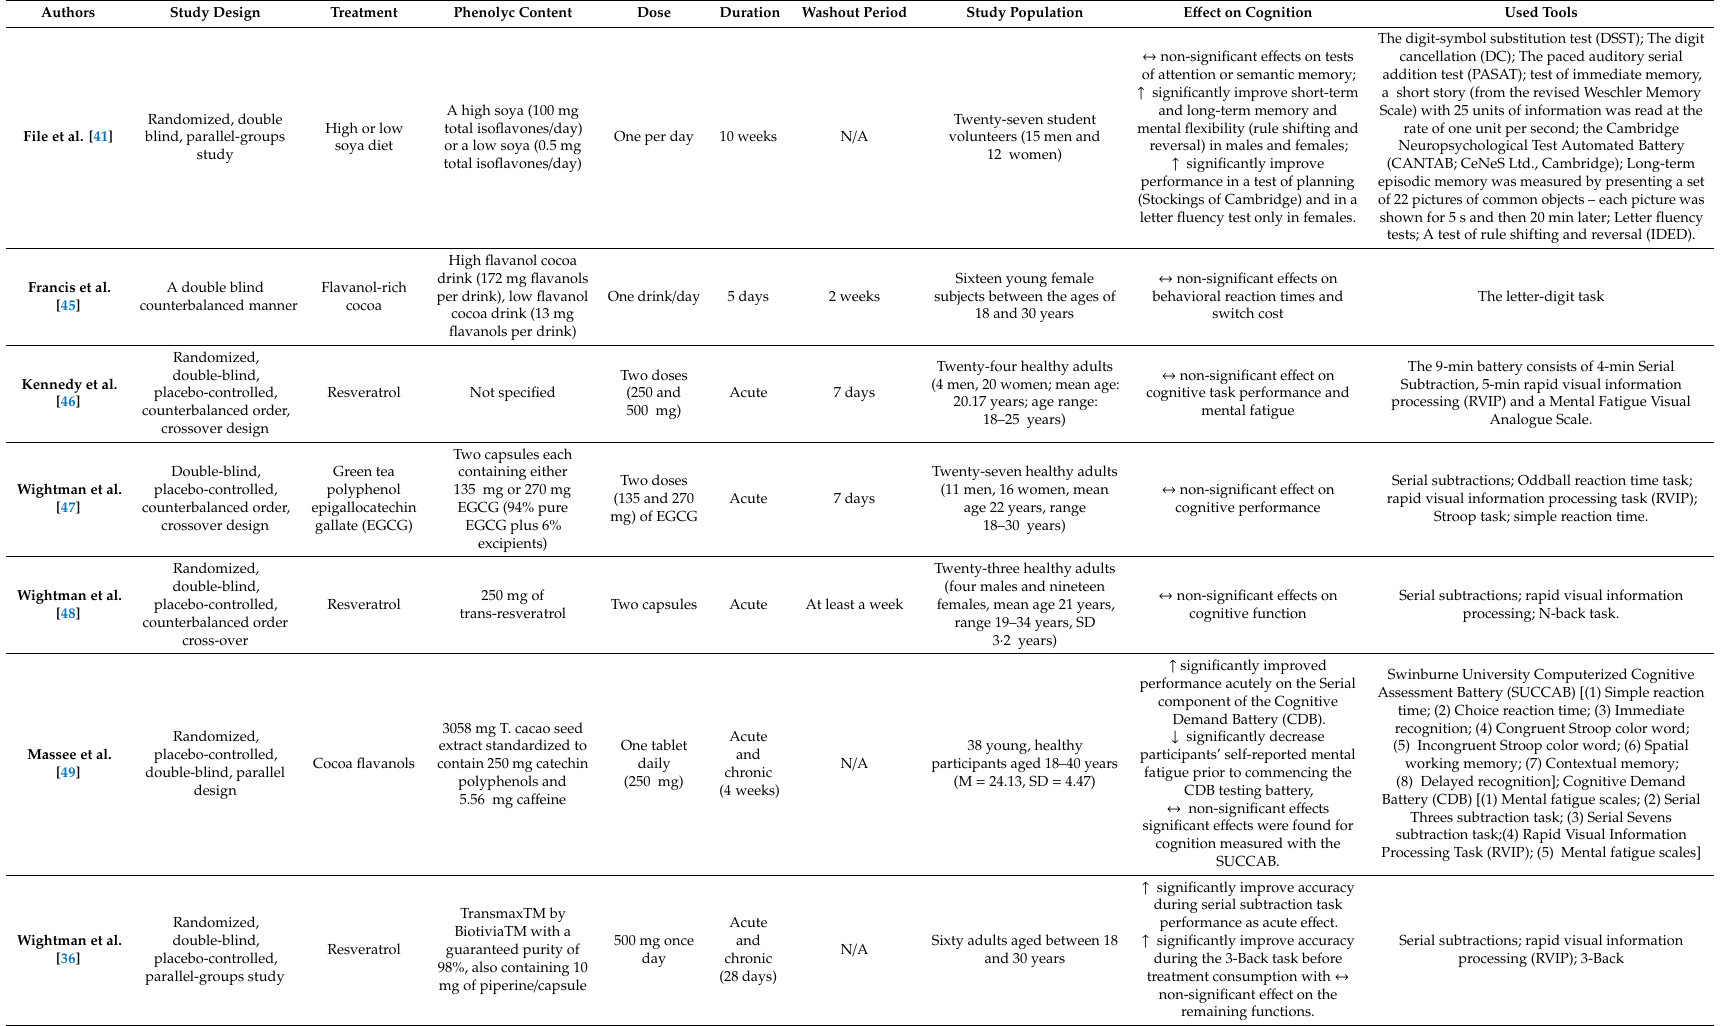
Table 1. E ff ect of polyphenol-rich supplementation on cognitive functions in young- and middle-aged